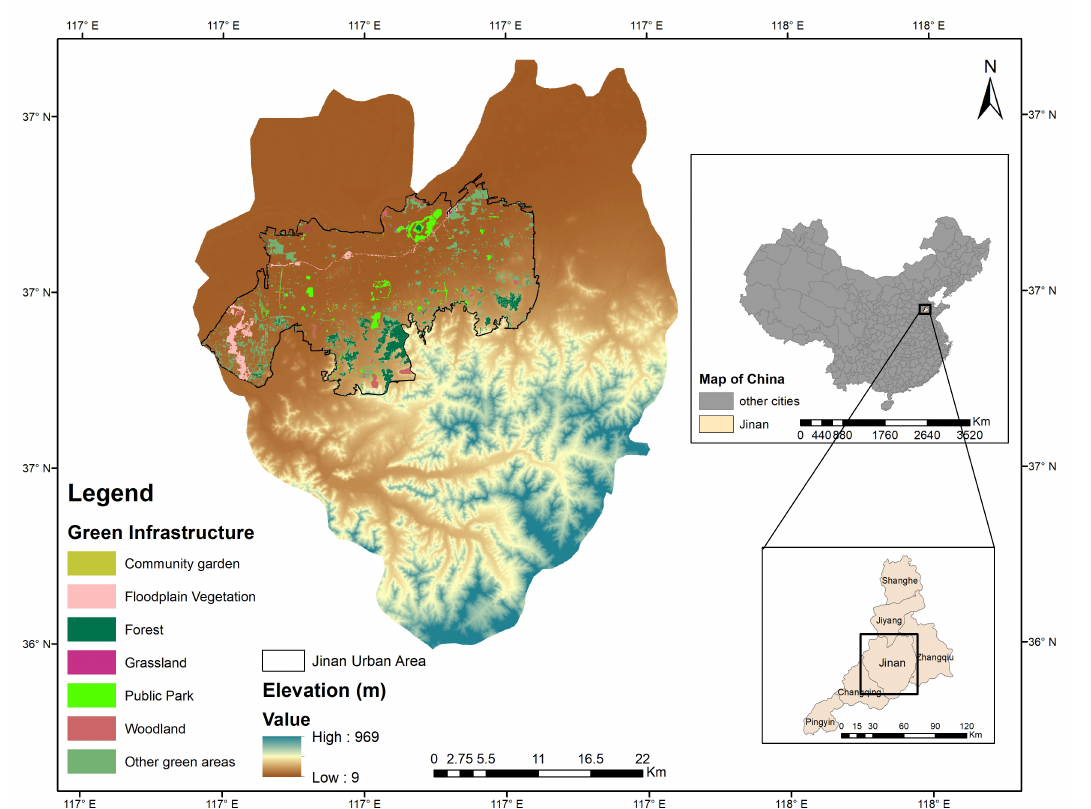
Figure 1. The geographical location of the study area: Location map of Jinan in China (top right), Jinan (bottom right), and Jinan urban area (top) showing multifunctional